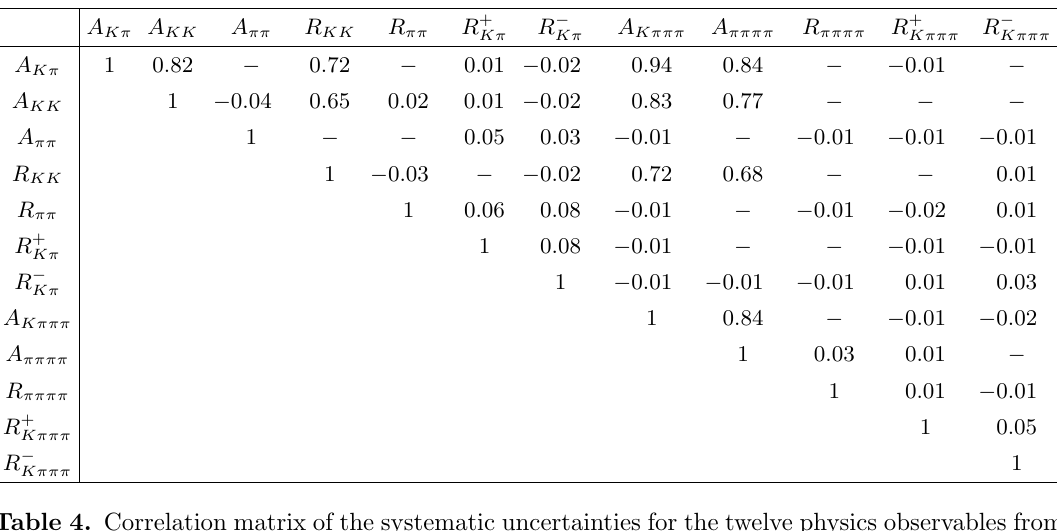
components whose relative amplitudes and phases are varied within limits according to the existing branching fraction measurements. The components used in the model